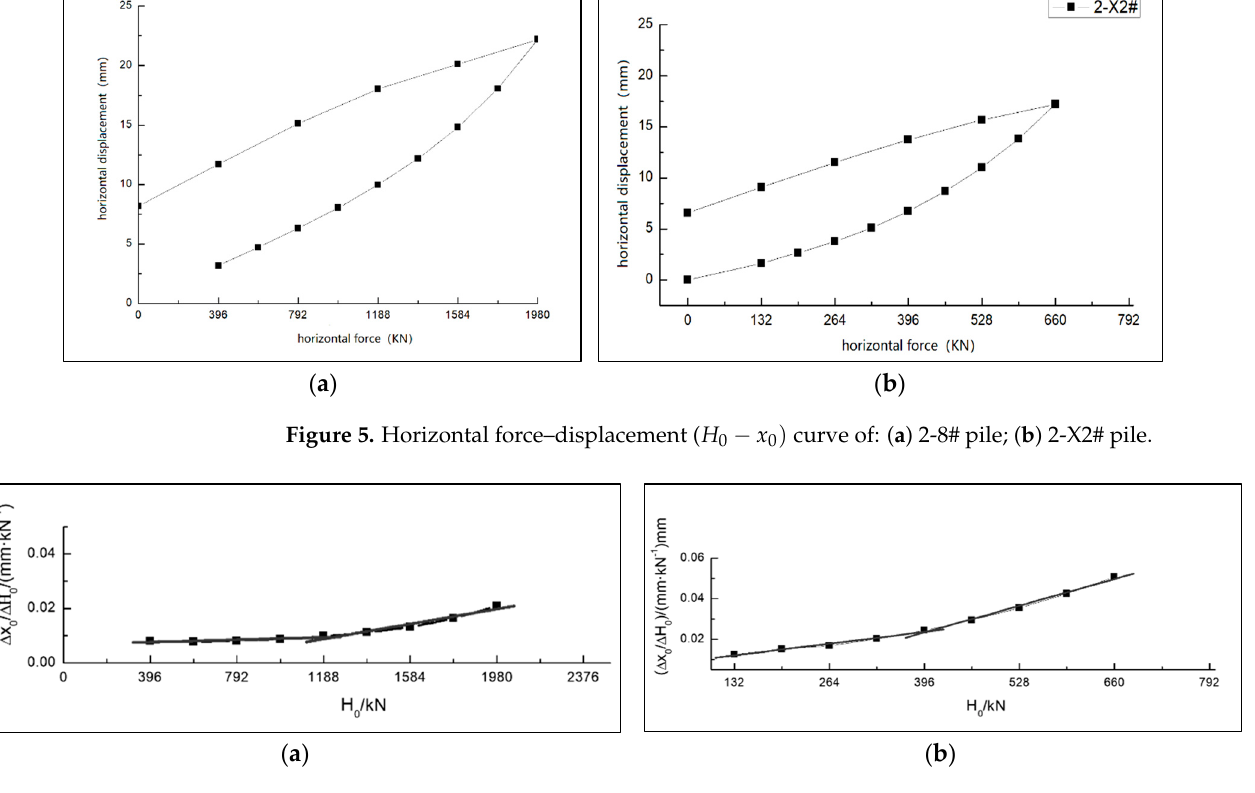
Figure 6. Horizontal force–displacement gradient ( H 0 − ∆ x 0 / ∆ H ) curve of: ( a ) 2-8# pile; ( b ) 2-X2# pile.